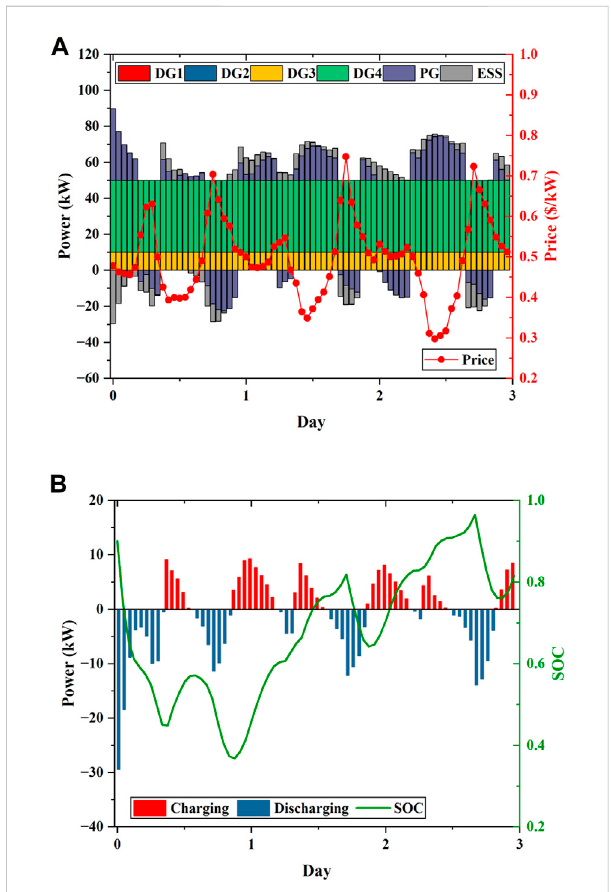
FIGURE 15 Scheduling results of the MG over three consecutive days in the test set: (A) Generation schedules of DGs, ESSs, and the main grid; (B) scheduled charging or discharging power and SOC of the ESS.